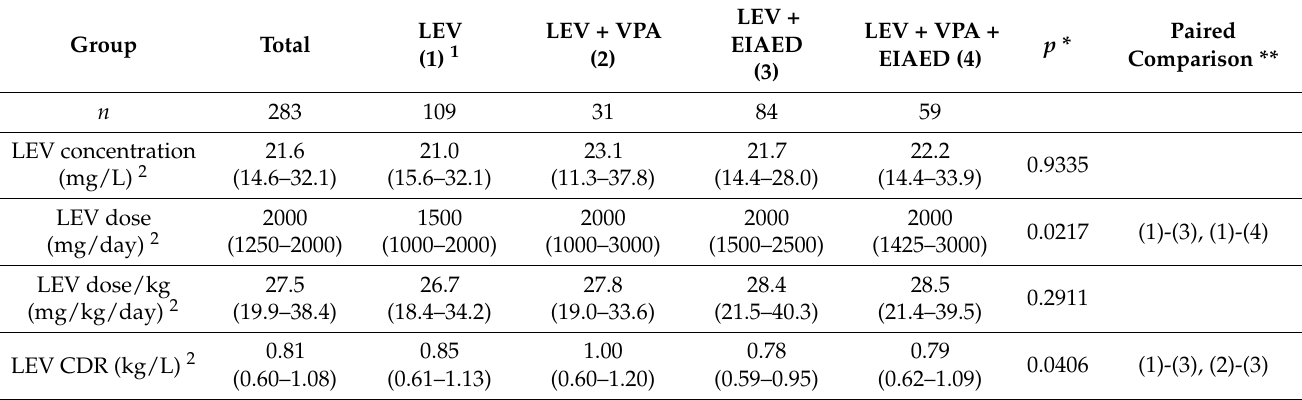
Table 3. Serum levetiracetam concentration, dose, and concentration-to-dose ratio for concomitant medication groups ( n =